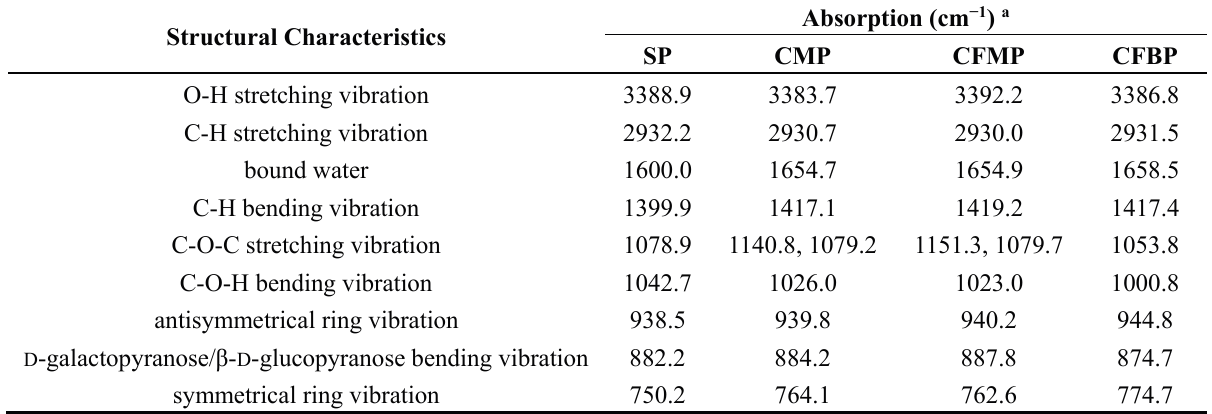
Table 3. FT-IR absorption bands of SP, CMP, CFMP and CFBP.